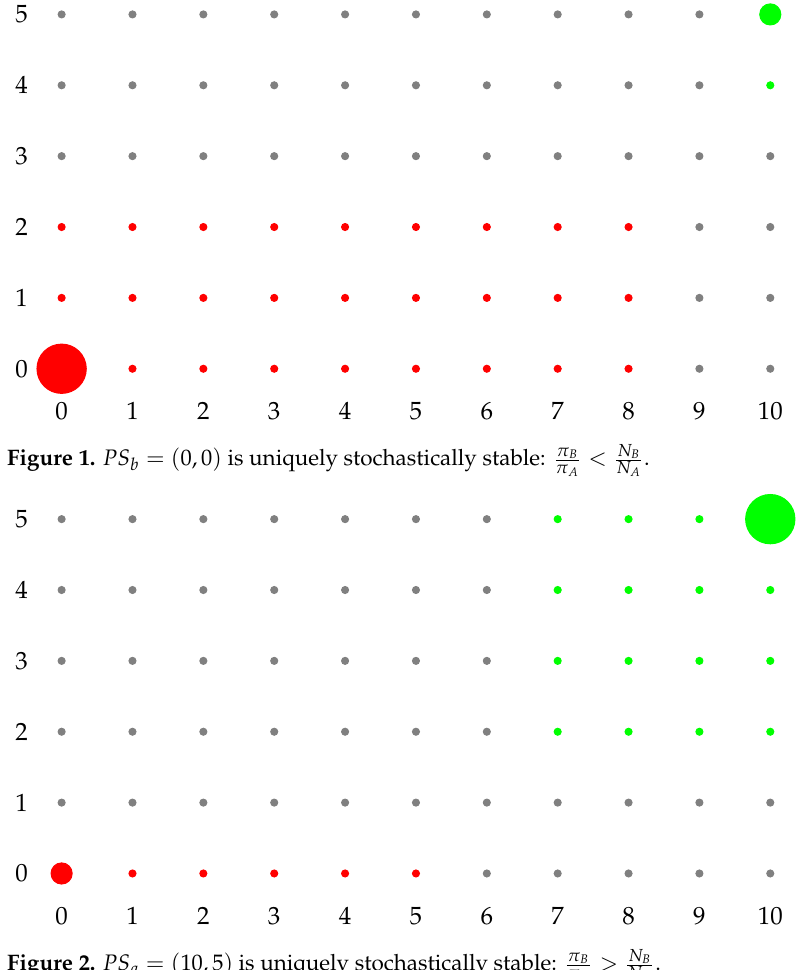
Figure 2. PS a = ( 10,5 ) is uniquely stochastically stable: π B